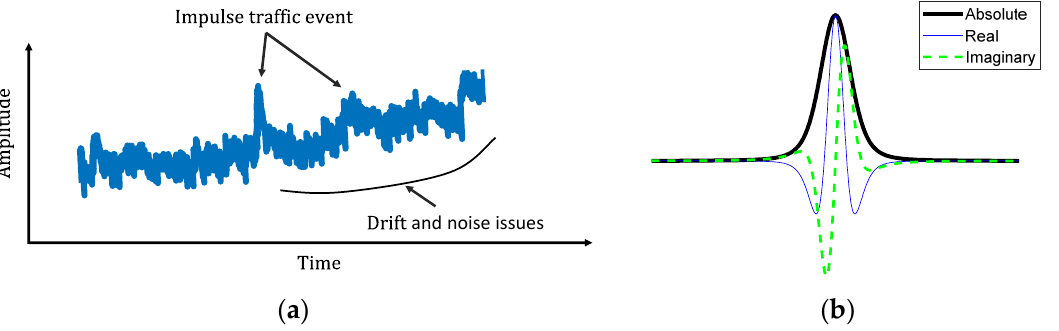
Figure 6. ( a ) A typical signal under traffic loading using the WLASS, and ( b ) The shape of the generalized Morse Wavelet with 𝛾 = 1.5 and 𝑃 (cid:2870) = 3 .